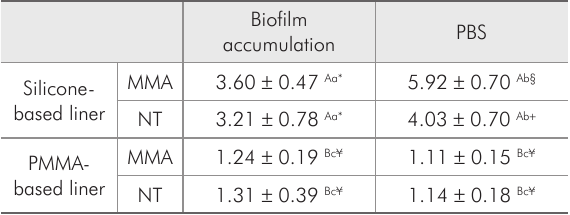
Table 1 - Tensile bond strength (mean ± SD, MPa) of soft liners to untreated (NT) or surface treated (MMA) PMMA following biofilm accumulation or PBS storage.